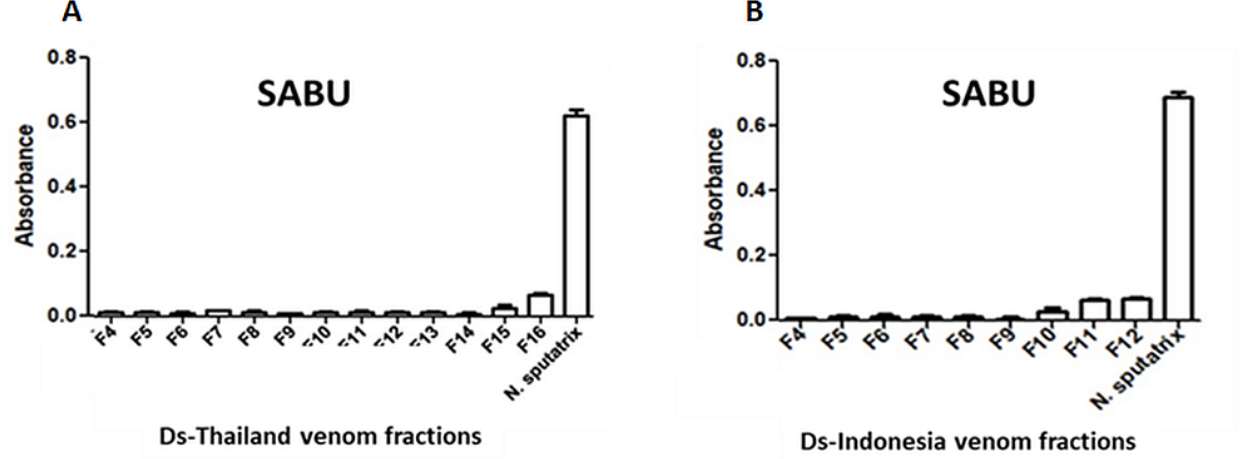
Figure 4. Immunoreactivity of Indonesian Serum Anti Bisa Ular (SABU) toward HPLC venom protein fractions of D. siamensis from (A) Thailand and (B) Indonesia. Naja sputatrix venom was used as positive control. Absorbance values were obtained by indirect ELISA and expressed as mean ± S.E.M. from three independent